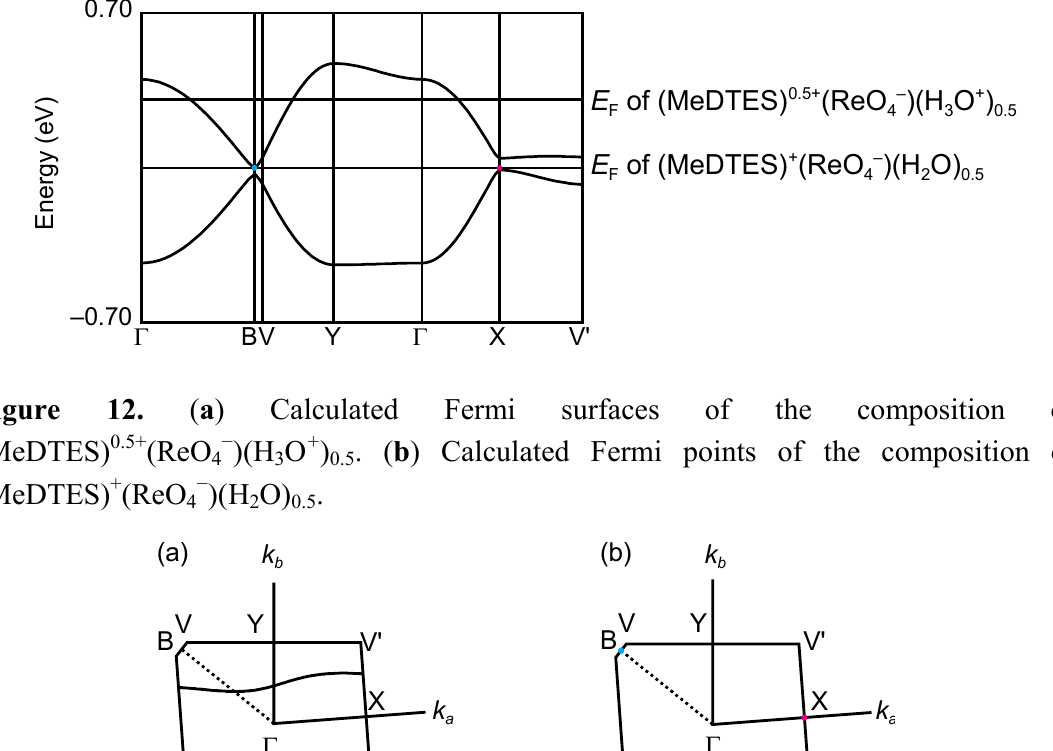
depends on the composition. F E of (MeDTES) 0.5+ (ReO 4– )(H F E of (MeDTES) + (ReO 4– )(H F